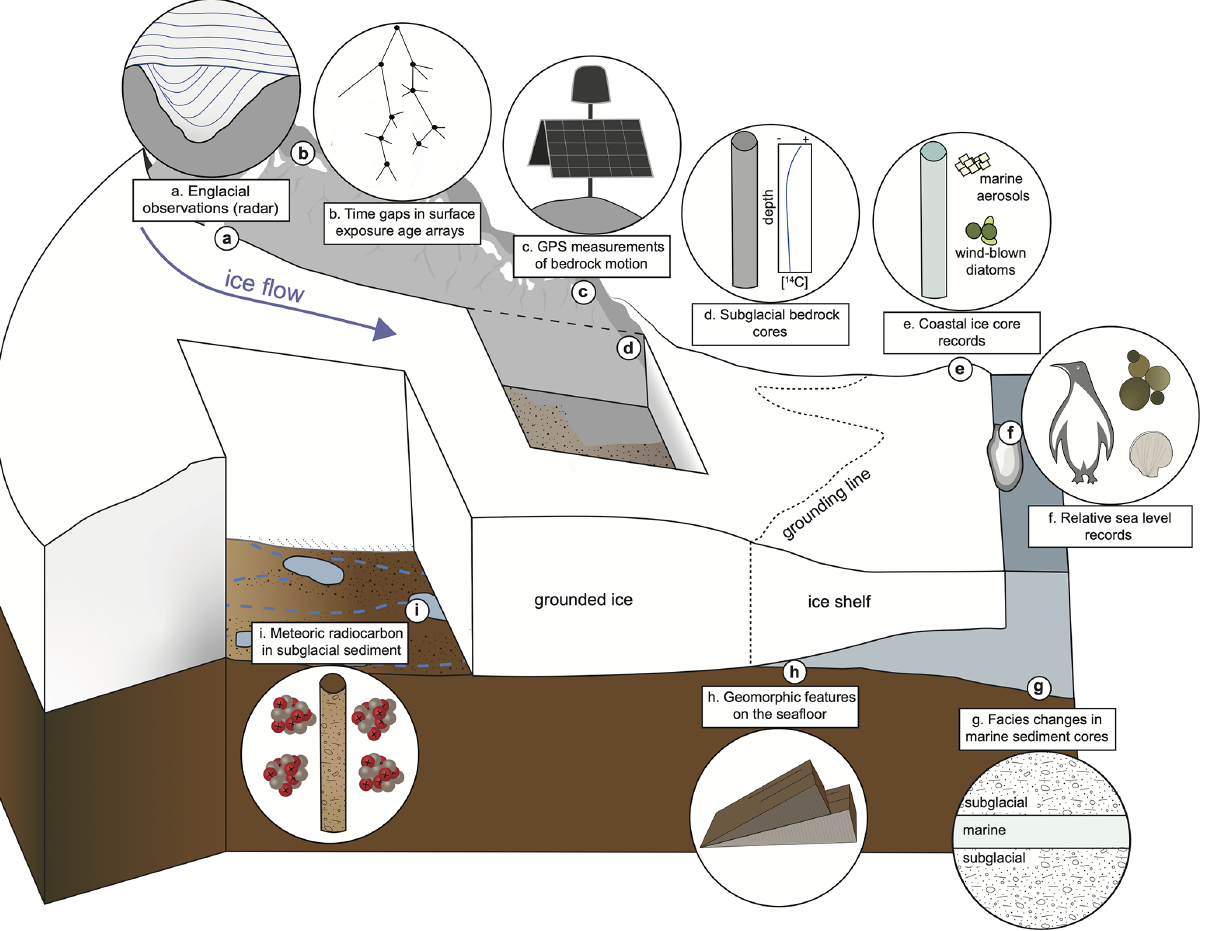
Figure 1. A recipe for reconstructing grounding line retreat and readvance during the Holocene. This schematic illustrates geological and glaciological records that may be used for palaeoglaciological reconstructions. These are discussed in the paper as follows: (a) englacial observations (Sect. 3.3.1), (b) exposure age arrays (Sect. 3.1.1), (c) geodetic observations (Sect. 3.1.4), (d) subglacial bedrock cores (Sect. 3.2.2), (e) ice cores (Sect. 3.3.2), (f) relative sea-level records (Sect. 3.1.3), (g) marine sediment cores (Sect. 3.1.2), (h) submarine geomorphic features (Sect. 3.1.2), and (i) subglacial sediments (Sect.